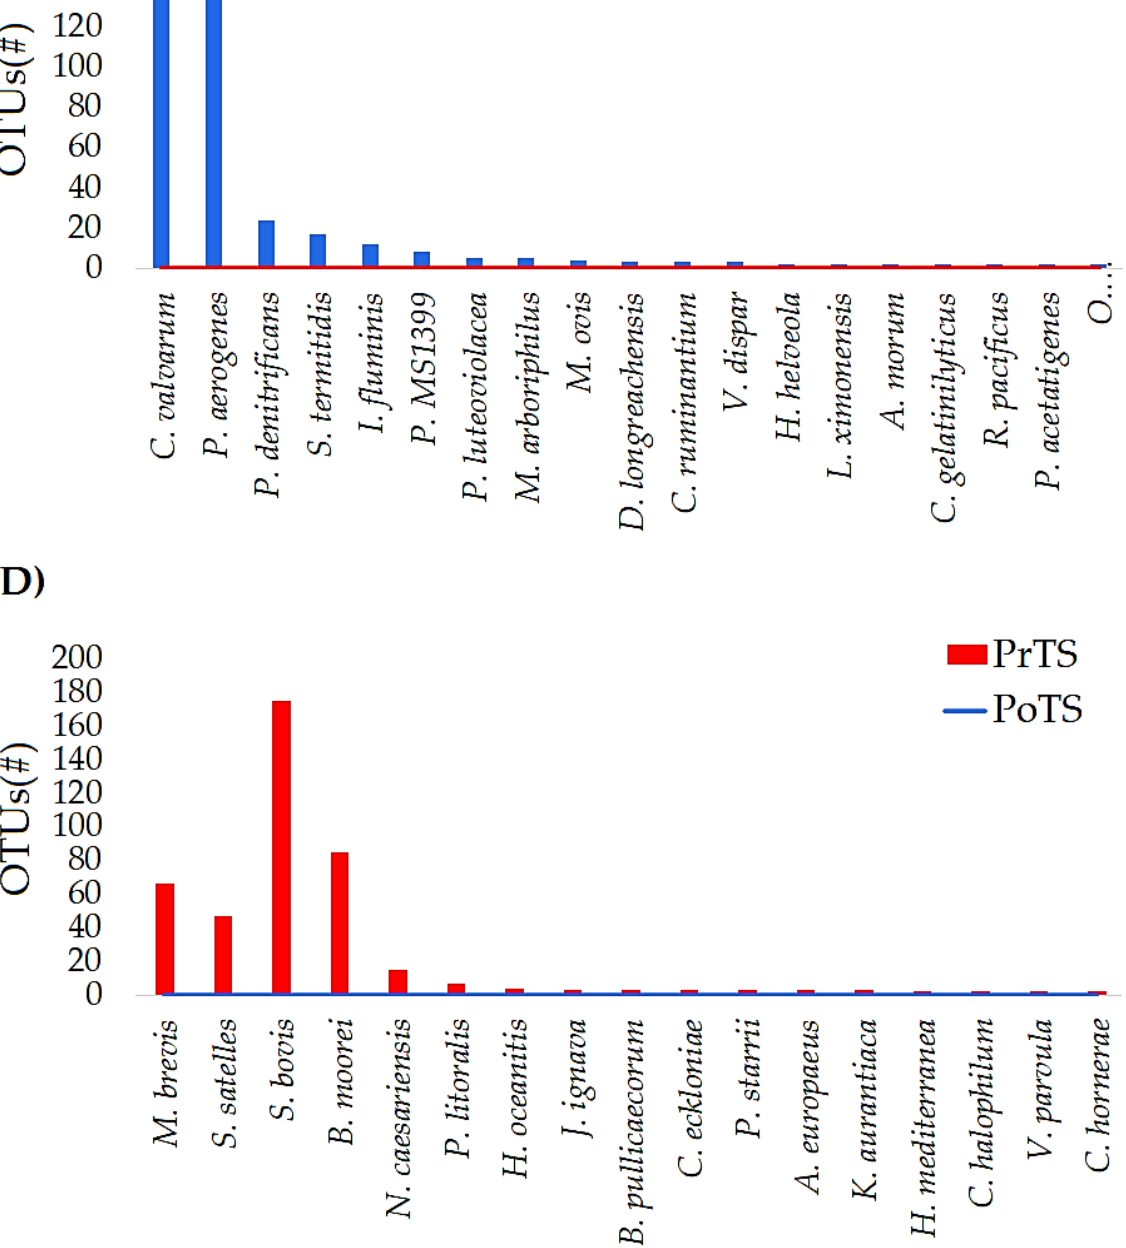
Figure 7. Comparison of the species-level relative frequency of the PrTS and PoTS samples of G2. The reduced ( A ), increased ( B ), newly evolved ( C ), and completely vanished ( D ) species in the control group after 42 days of study were reported.